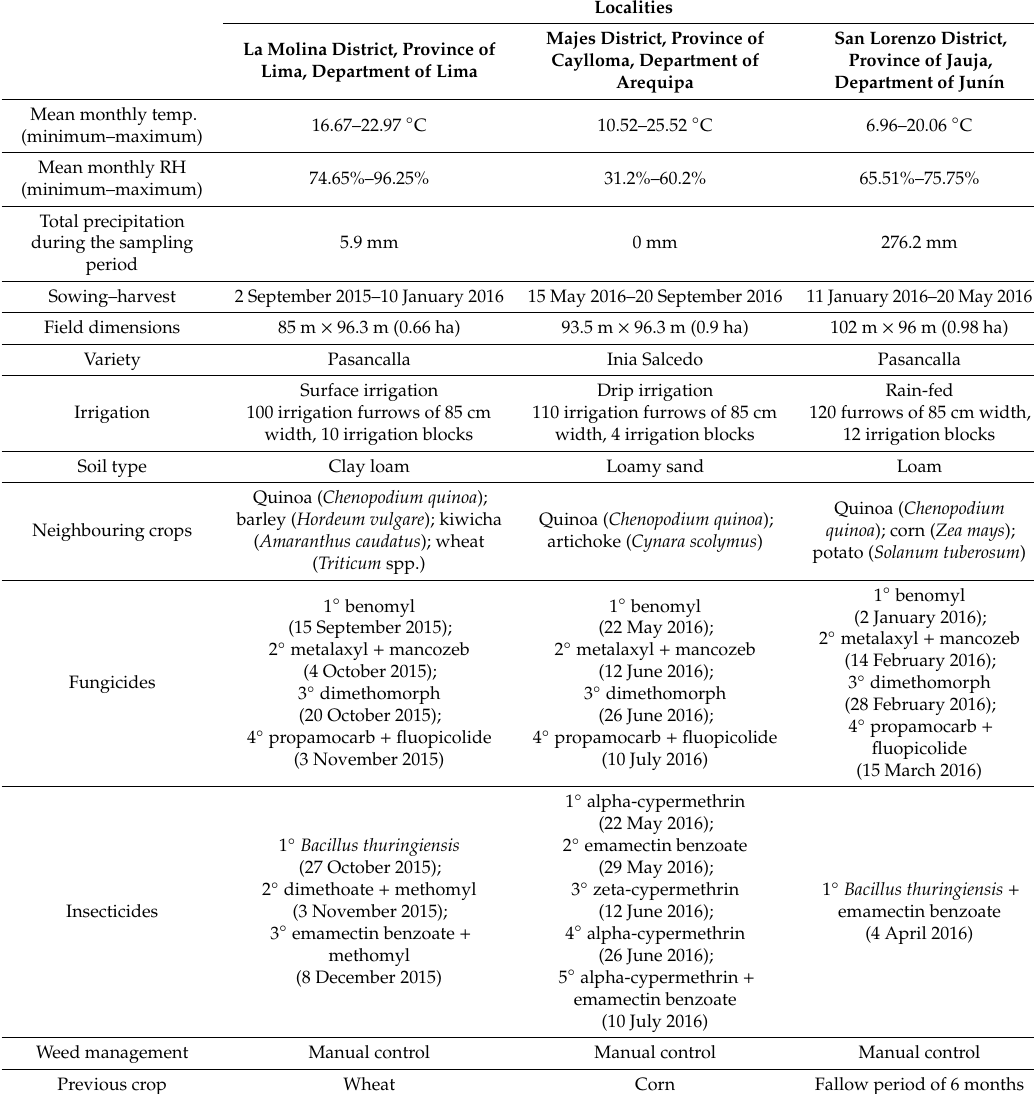
Table 1. Growing specifications for quinoa during the sampling period in the localities of La Molina, Majes and San Lorenzo